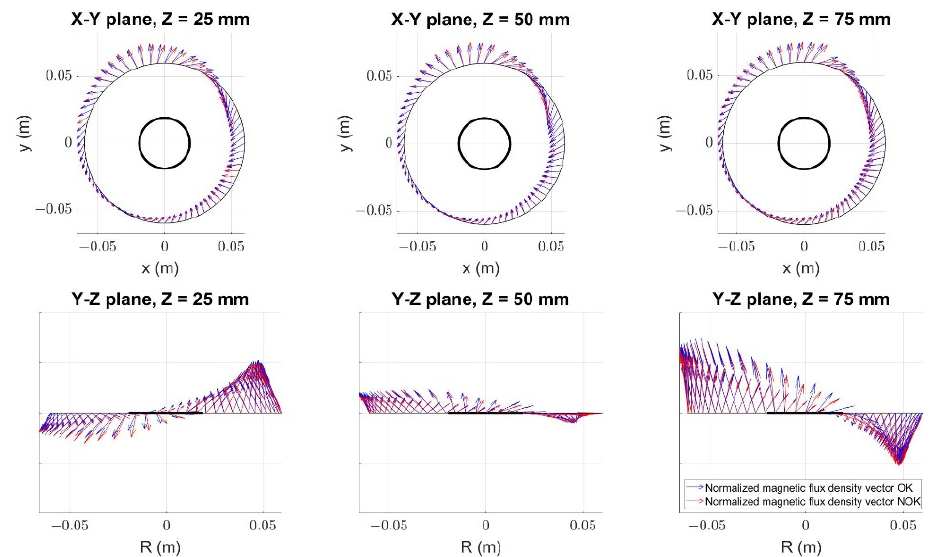
Figure 6. Stray magnetic field orientation in 3 horizontal planes, for the OK (blue) and NOK (red) rotation directions, for R = 60 mm.